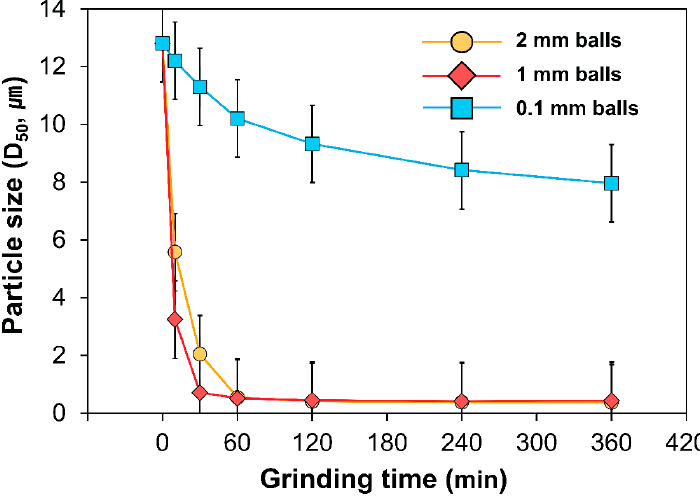
Figure 7. Change of particle size (D 50 ) of talc upon grinding.